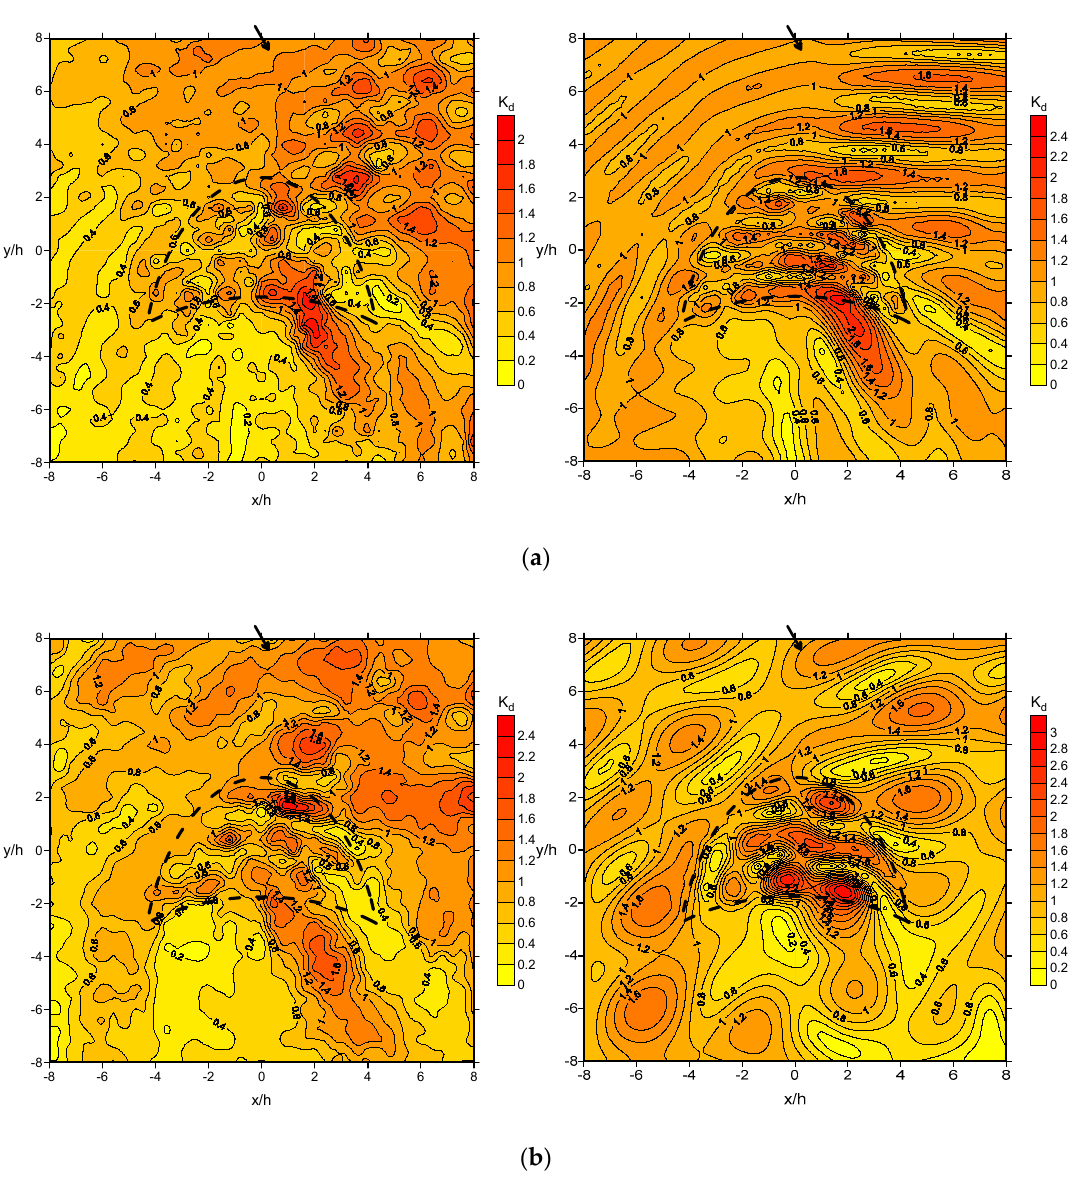
Figure 8. Comparison of the experimental (left) and numerical (right) wave fields for wave conditions of ( a ) σ 2 h / g = 2.012 and ( b ) σ 2 h / g = 0.894 at oblique incidence ( α = 120 ◦ )